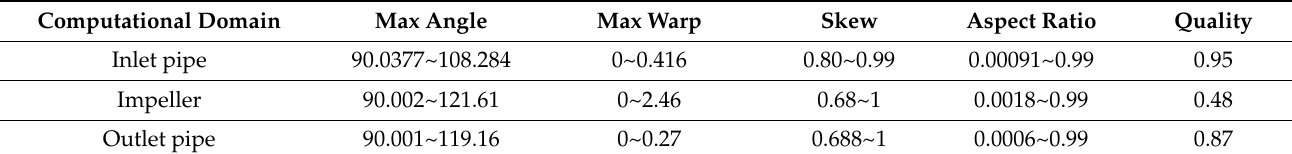
Figure 2. Computational mesh ( a ) inlet pipe; ( b ) outlet pipe; and ( c ) impeller. Table 1. Mesh quality. Table 1. Mesh quality.